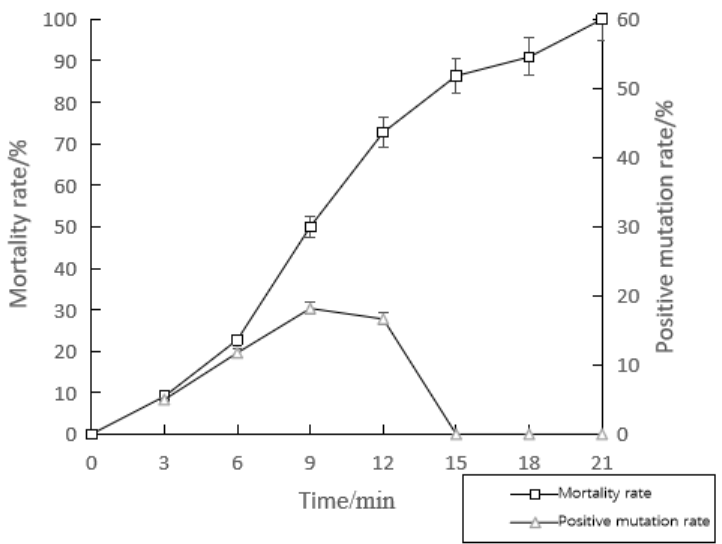
Figure 1. The mortality and positive mutation rate of strain HNCMBJ-P-01 by UV mutagenesis. Bars represent standard errors of three replicates.